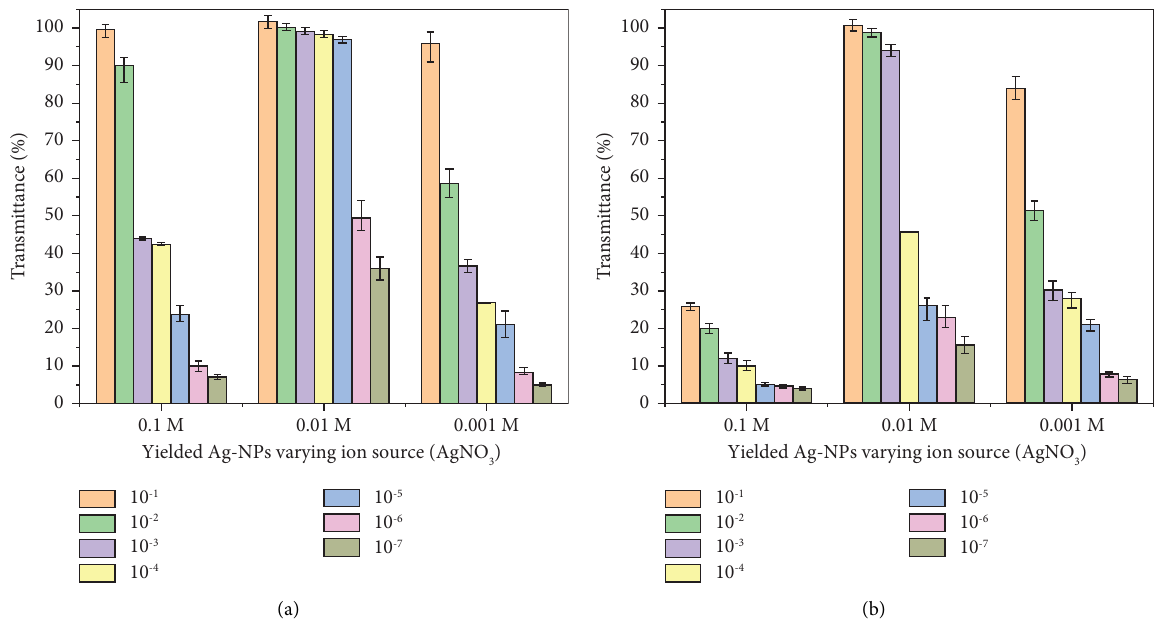
Figure 11: Measurement of transmittance (%) for determination of the minimum inhibitory concentration of Ag-NPs on turbidity based using UV-Vis spectroscopy for (a) Bacillus spp. and (b) Pseudomonas